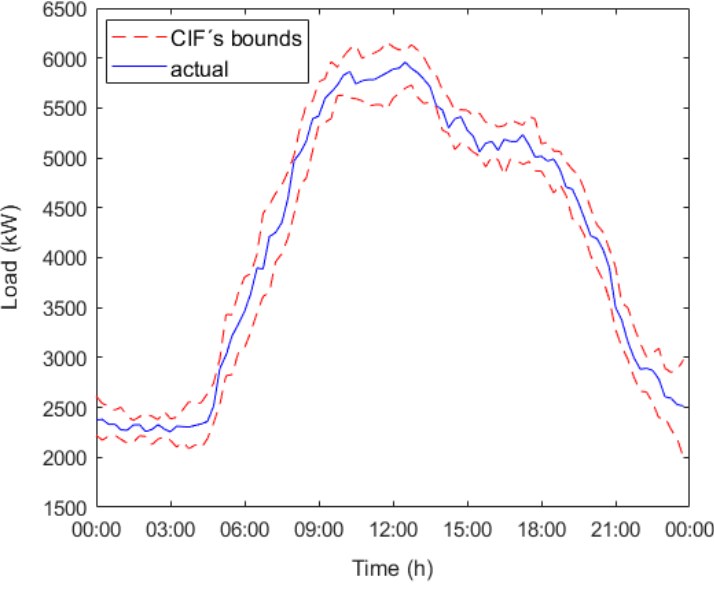
Figure 3. Predicted intervals and actual energy demand evolution for 8 February 2018 scenario (𝛼 = 0.05 , 𝐹 = 1560) .